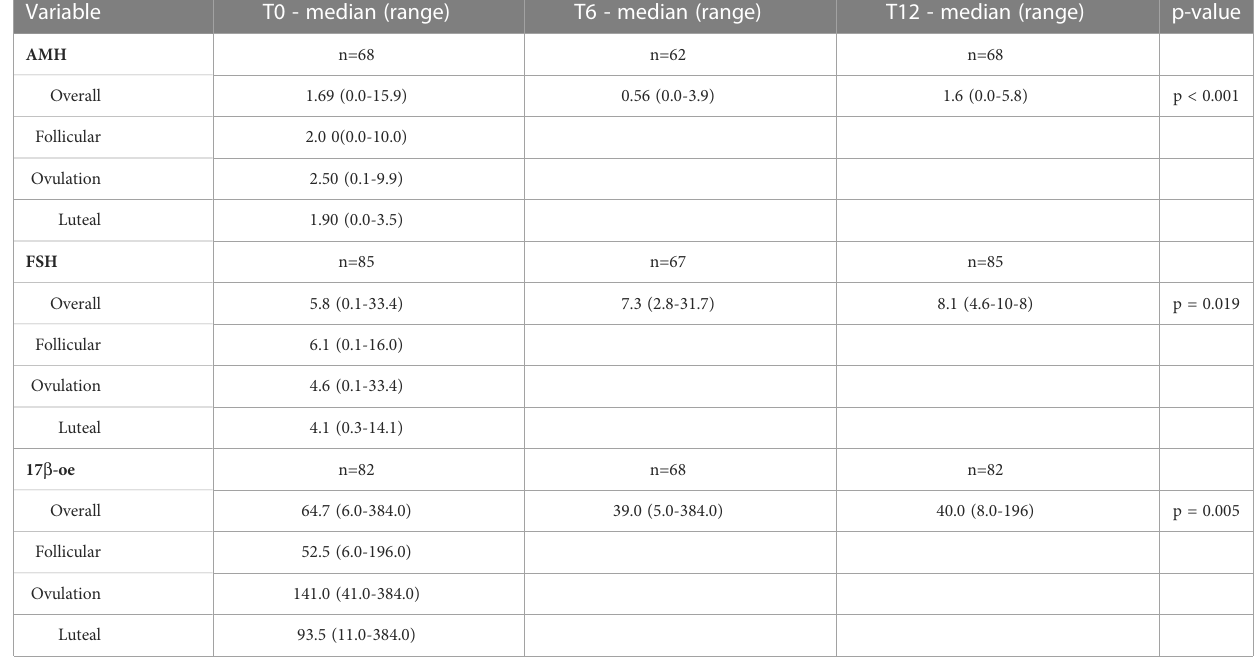
TABLE 2 AMH, FSH and 17 b -oe levels at baseline (overall and according to the menstrual cycle phase) and during the follow ‐ up